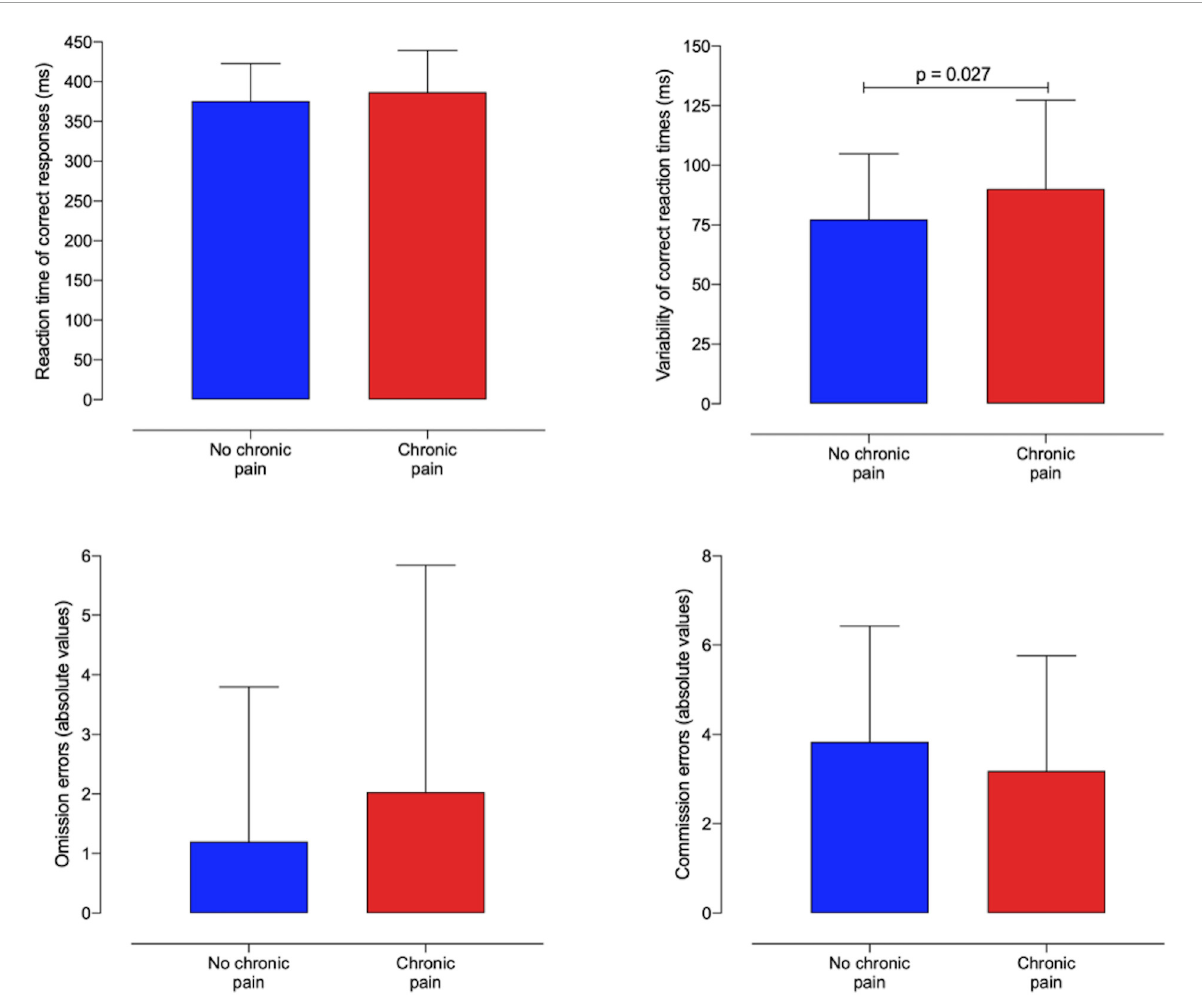
FIGURE3 Continuous Visual Attention Test (CVAT) performance. Bar graphs displaying mean with standard deviation per group for each CVAT variable. Chronic pain (CP) patients present higher reaction time variability than non-CP